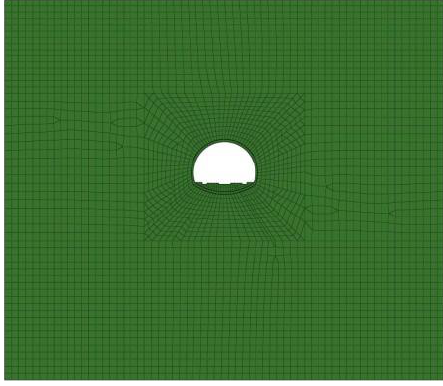
Table 4. Main parameters of model material.